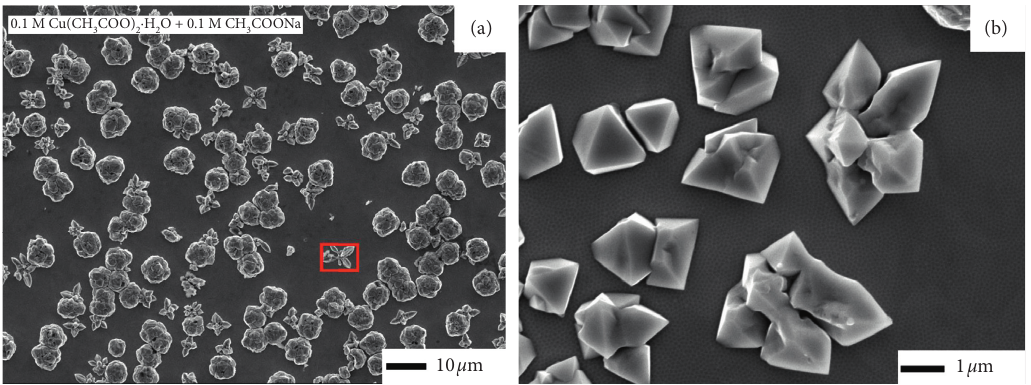
Figure 8: SEM images of electrodeposition of the CuO-Cu